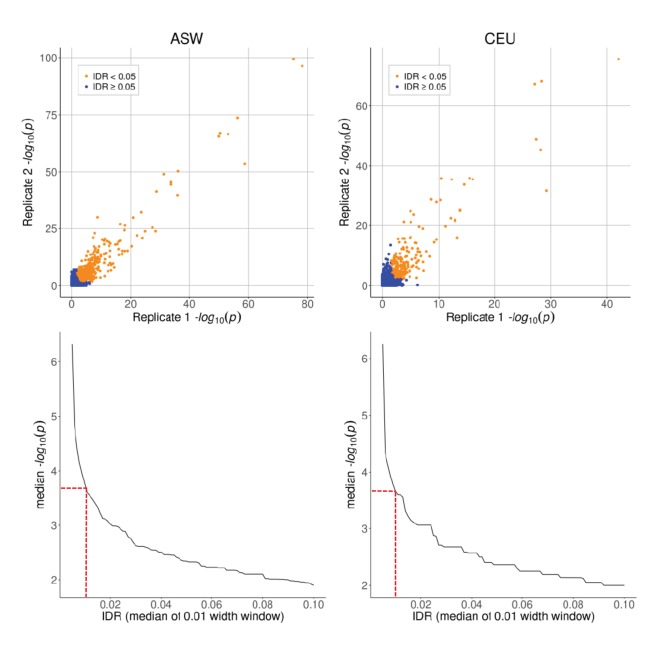
Top row: caQTL p-values for SNPs on chr one in ASW and CEU, shown separately for each biological replicate.Bottom row: median –log10(p-value) as a function of IDR, plotted using a moving window of IDR values (window width = 0.01). Dashed red lines indicate the p-value cutoff of 5 × 10−4, corresponding to IDR ≈ 0.01.